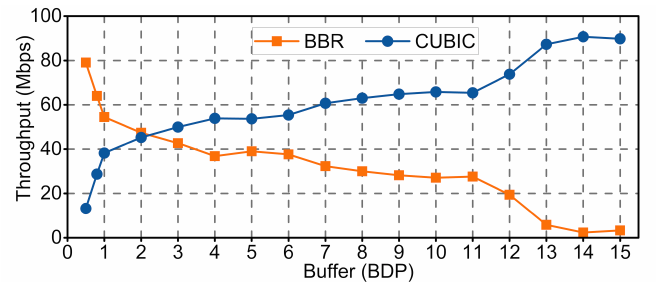
Figure 4. Throughput of BBR and CUBIC according to the buffer